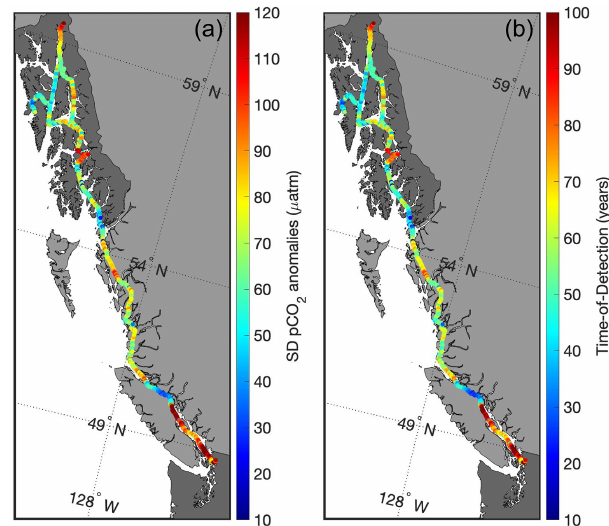
Figure 7. Standard deviation of p CO 2 anomalies (µatm; a ) and the time of detection (years; b ) to resolve the secular trend of increasing seawater p CO 2 that tracks the contemporary rise in atmospheric CO 2